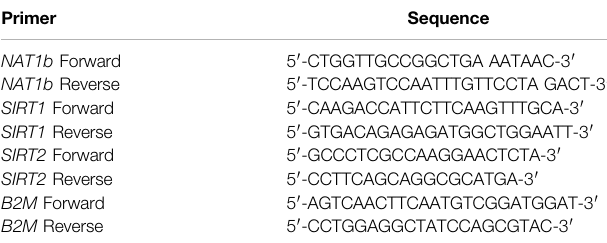
TABLE 1 | Sequences of the primers used for the mRNA transcript expression.